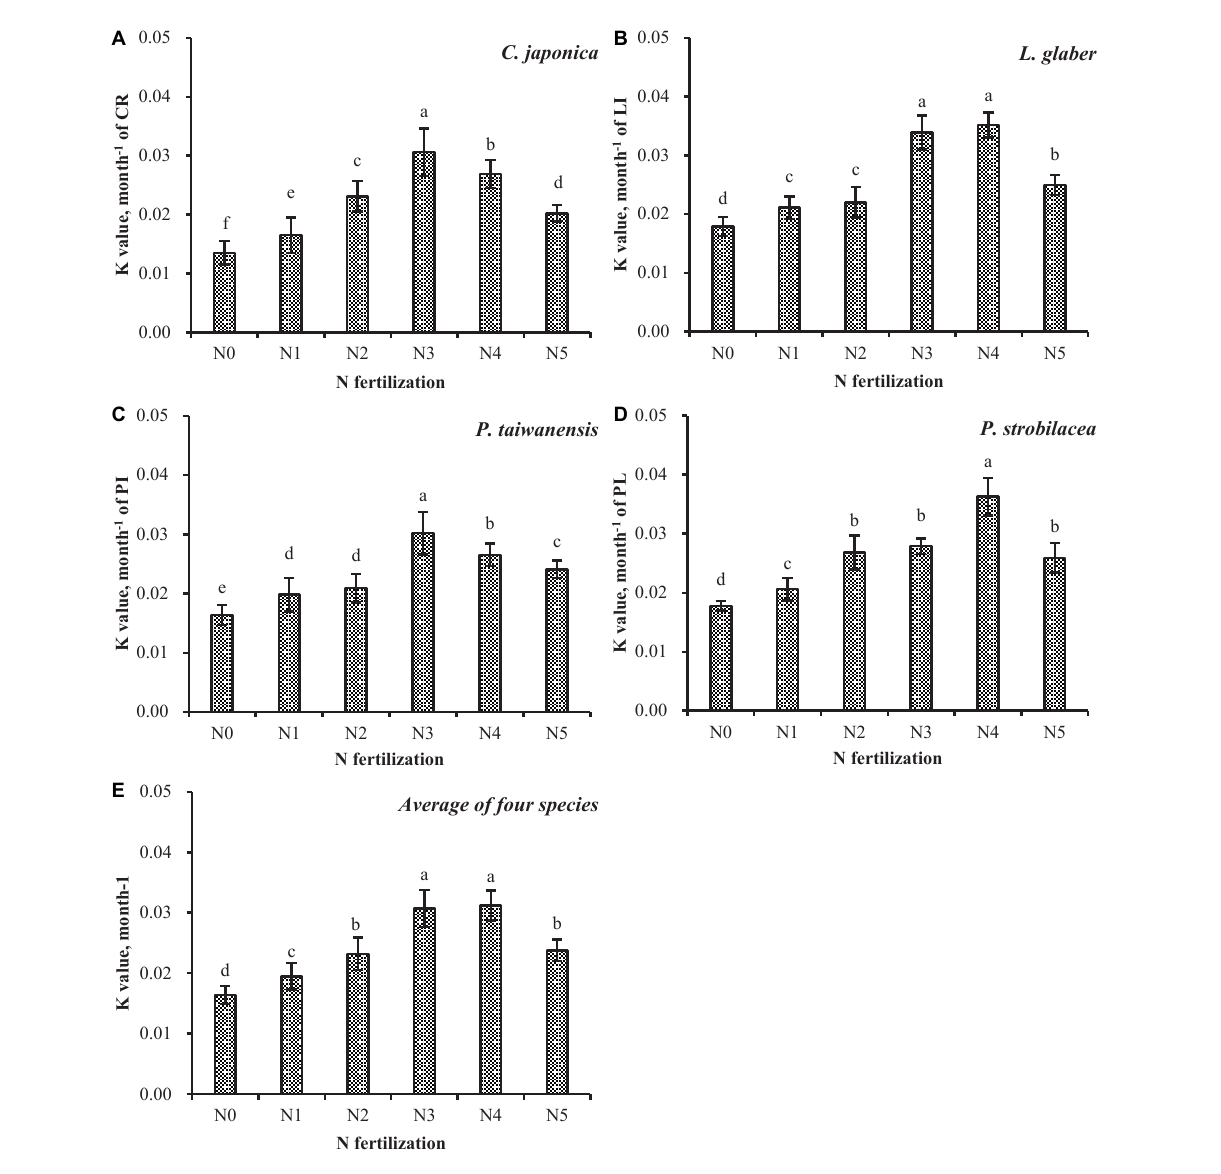
FIGURE2 Wood decomposition rates (k) of the four studied species (A–D) and the average of the four species (E) for the different N fertilization treatments. Error bars indicate the standard error ( n = 6). Bars with different letters differ significantly among different forms of N fertilizer at p < 0.05. N5, IN:ON = 0:10; N4, IN:ON = 3:7; N3, IN:ON = 5:5; N2, IN:ON = 7:3; N1, IN:ON = 10:0 and N0, Control. Cryptomeria japonica ( C. japonica ), Platycarya strobilacea ( P. strobilacea ), Pinus taiwanensis ( P. taiwanensis ), and Lithocarpus glaber ( L. glaber